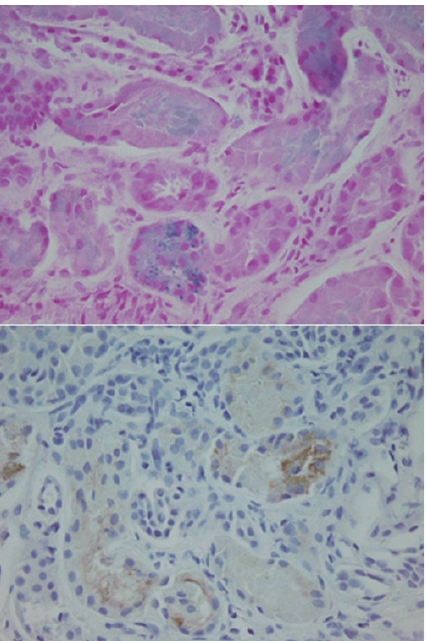
Figure 3: Native renal biopsy with sickle cell nephropathy associ- ated iron deposition and acute tubular injury. A 17-year-old male, with a medical history of SCD, developed acute renal failure. FindingsofhisrenalbiopsywereconsistentwithSCN.Toppanel:the proximal tubules were deposited with large amount of iron broken from sickle red blood cells (positive Prussian blue iron staining). Bottom panel: the iron-associated nephrotoxicity in the proximal tubules was confirmed by positive KIM-1 staining. (Top and bottom panels, original magnification ×